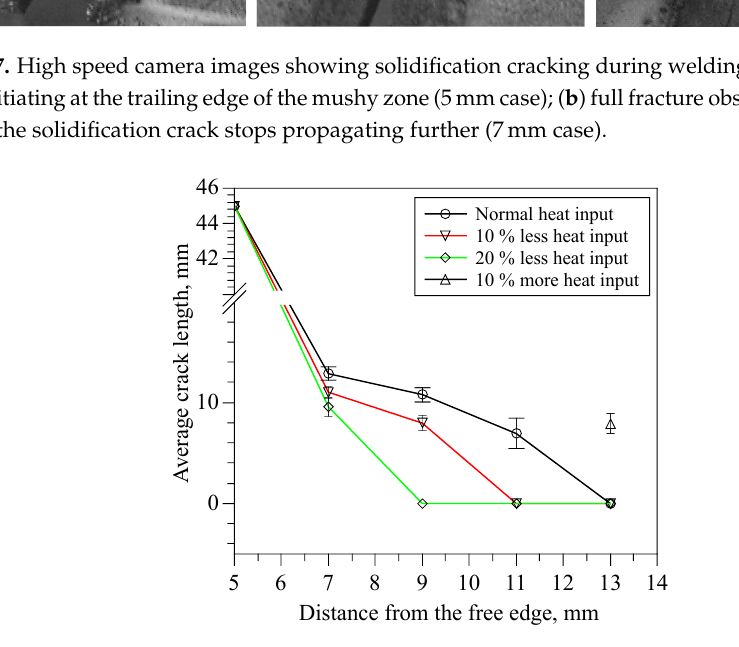
Figure 8. Measured crack length for the set of experiments.